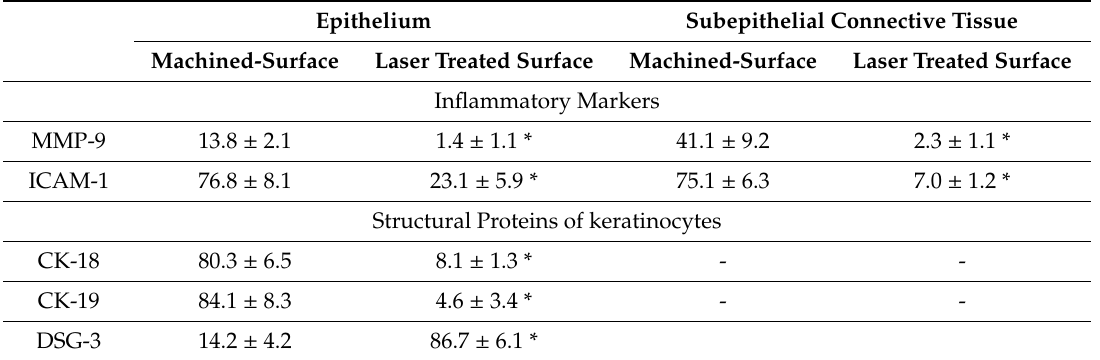
Table 1. Evaluation of inflammatory markers and cytokeratins expression in soft tissues facing machined or nanopored laser-treated healing